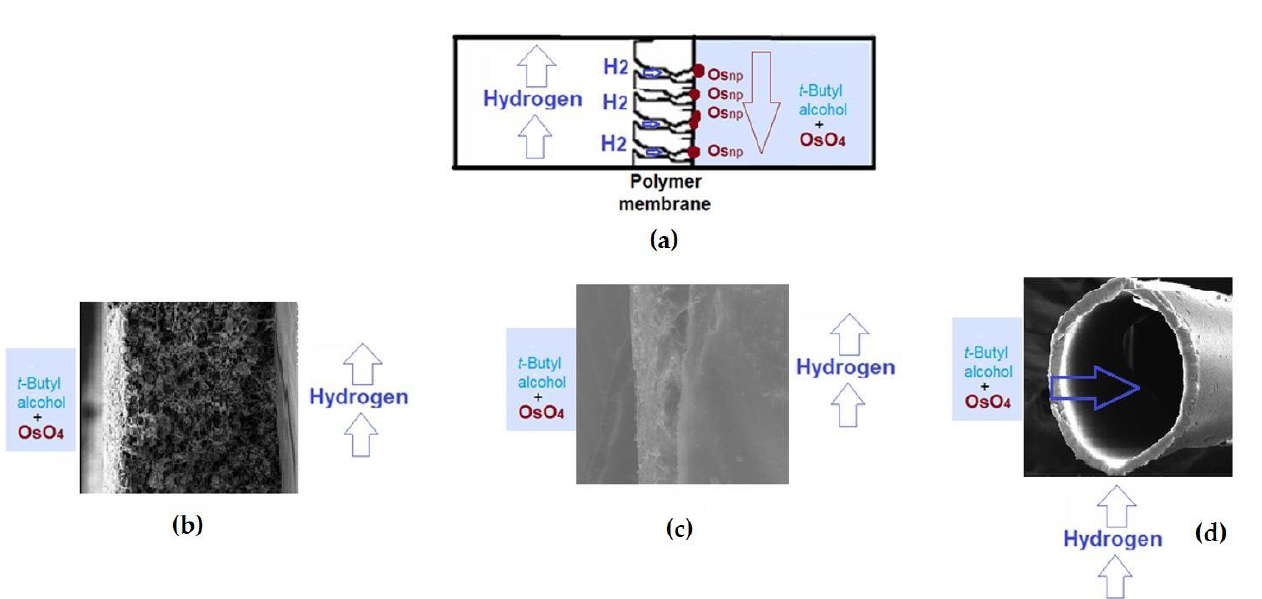
Figure 4. The schematic presentation for obtaining the composite osmium nanoparticles (Os np ) – polymer membranes: ( a ) general scheme; and cases: ( b ) cellulose acetate membrane; ( c ) polysulfone membrane; ( d ) polypropylene hollow fiber membrane.